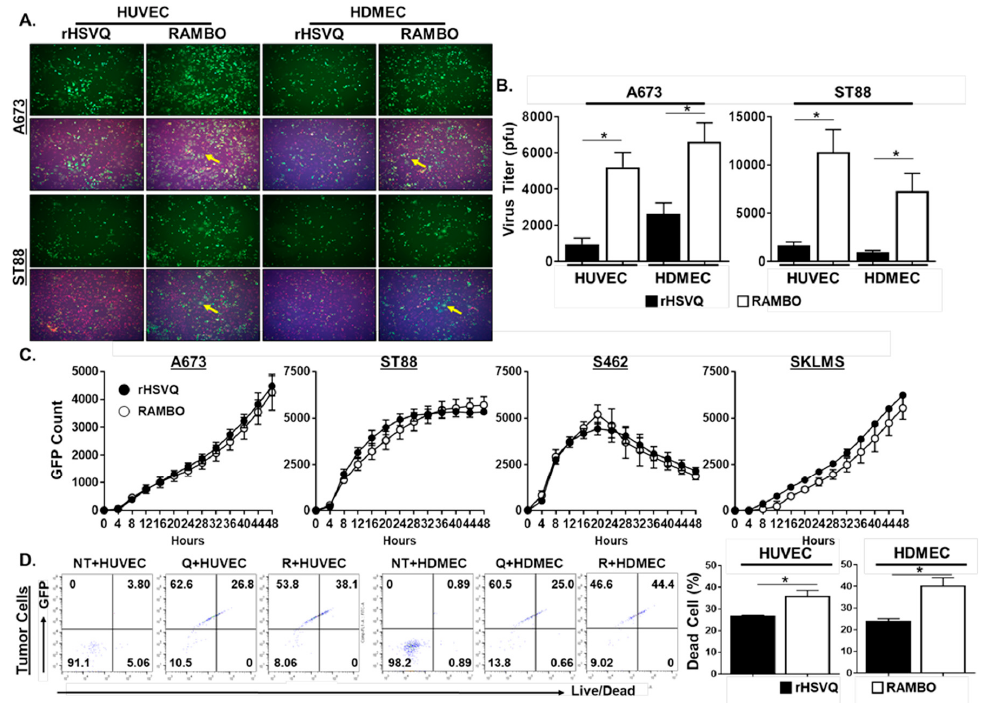
Figure 4. RAMBO increases virus replication in sarcoma and endothelial cell coculture condition. ( A